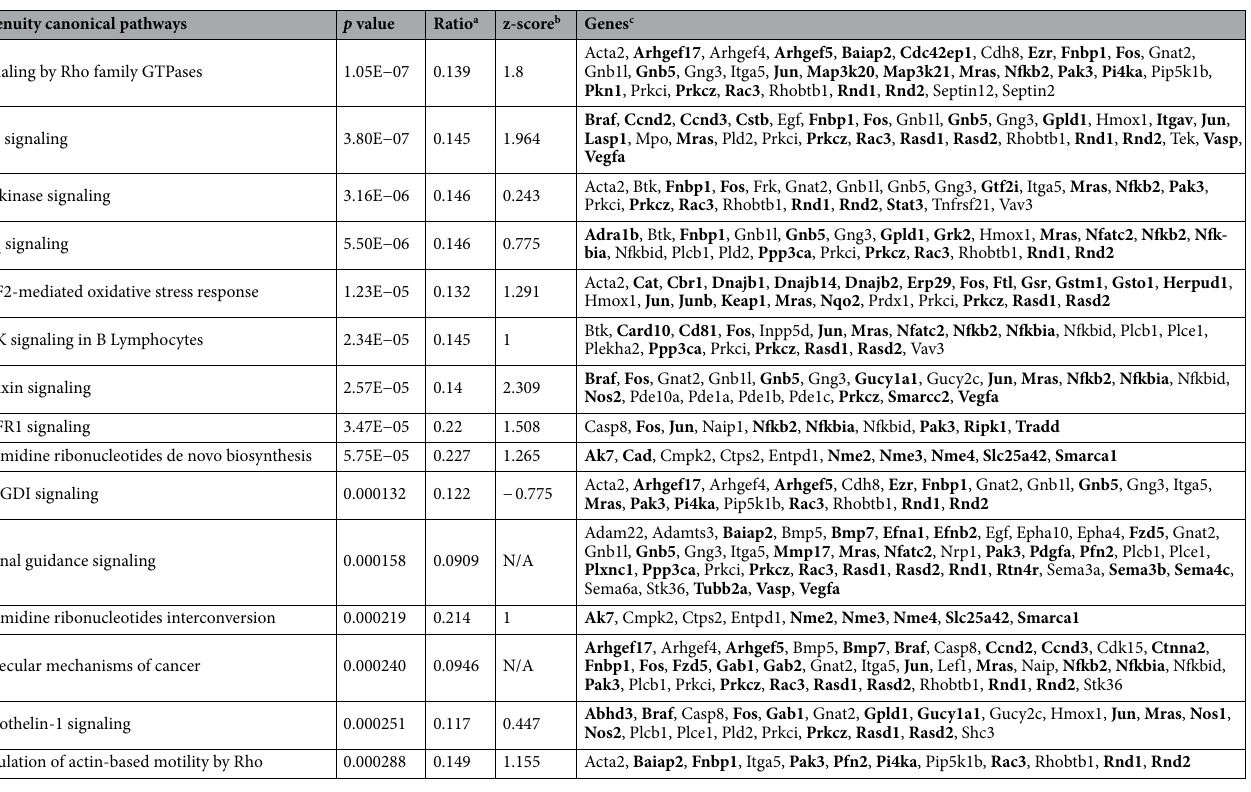
Table 1. Top 15 canonical pathways of differentially expressed genes between secondary follicle oocytes of mature and premature mice. N/A not available. a Ratio of listed genes found in each pathway over the total number of genes in that pathway. b z-score positive when pathways are up-regulated in mature mice and negative when pathways are up-regulated in premature mice. c Genes in bold are up-regulated in mature mice, while genes in normal font are up-regulated in premature